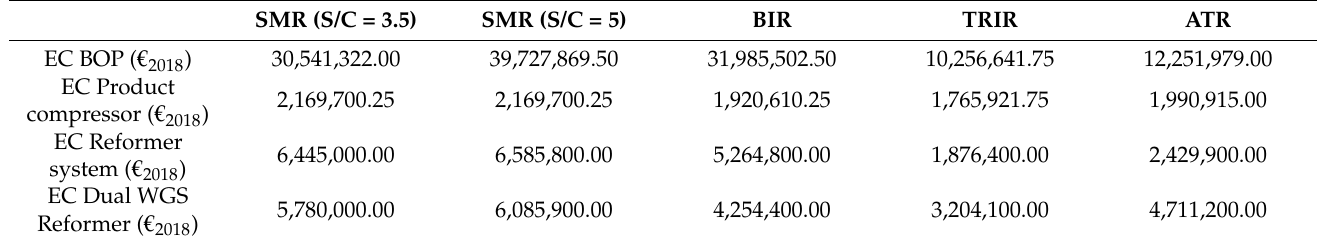
Table 7. Purchase equipment costs of different reforming systems.